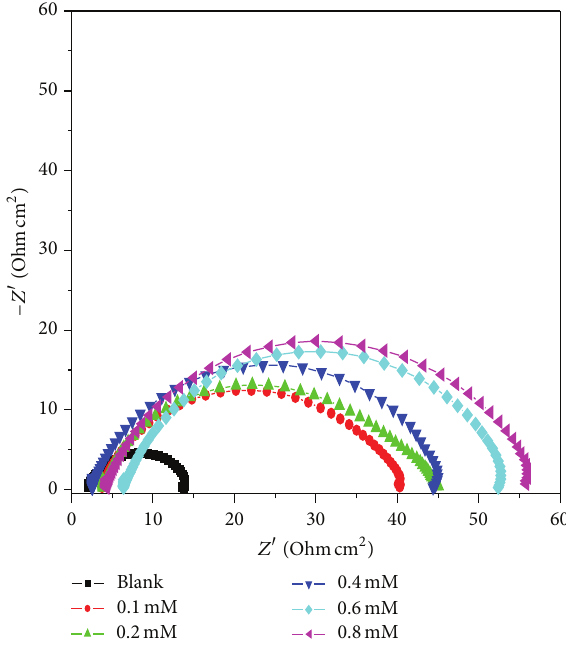
Figure 5: Nyquist plots for the mild steel specimen in 1M HCl acid containing different concentrations of HIBH at 40 ∘